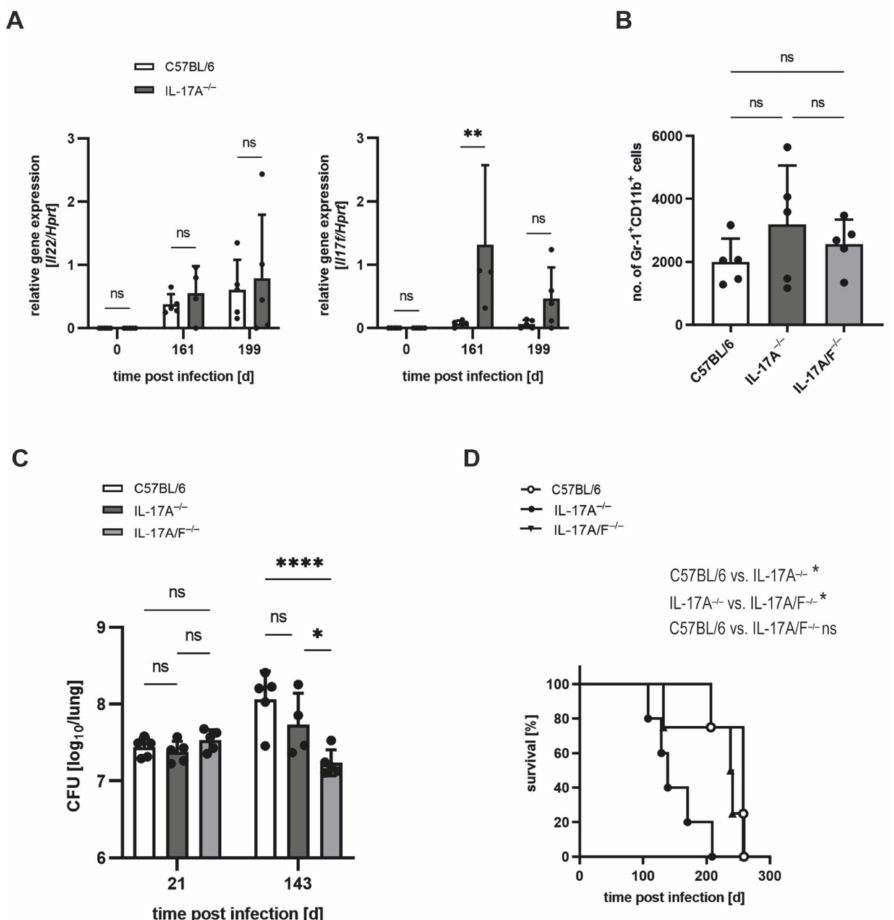
Figure 7. IL-17F mediates impaired survival in Mtb-infected IL-17A − / − mice without exerting a significant influence on the numbers of neutrophils in the lung. ( A – D ) C57BL/6, IL-17A − / − , and IL-17A/F − / − mice were infected with 100–1000 CFU of H37rv Mtb by an aerosol. ( A ) At different time points of infection, gene expression levels of Il22 and Il17f were quantified by real-time